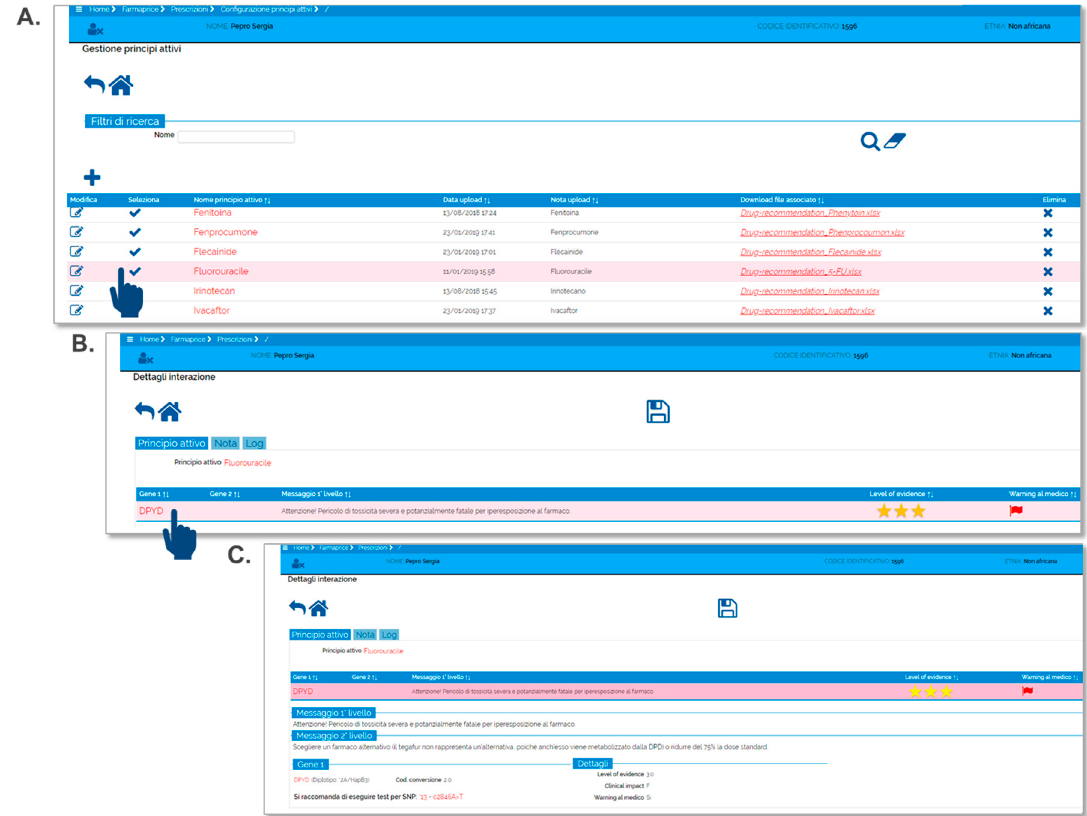
Figure 2. Demo prescription using FARMAPRICE tool. ( A ) the physician prescribes 5-fluorouracil to a patient who is DihydroPYrimidine-Dehydrogenase ( DPYD ) poor metabolizer. ( B ) This action triggers a pop-up with a first level message. ( C ) This in turn can trigger the real PGx-based recommendation of drug selection or dosage by clicking directly on the first level message.